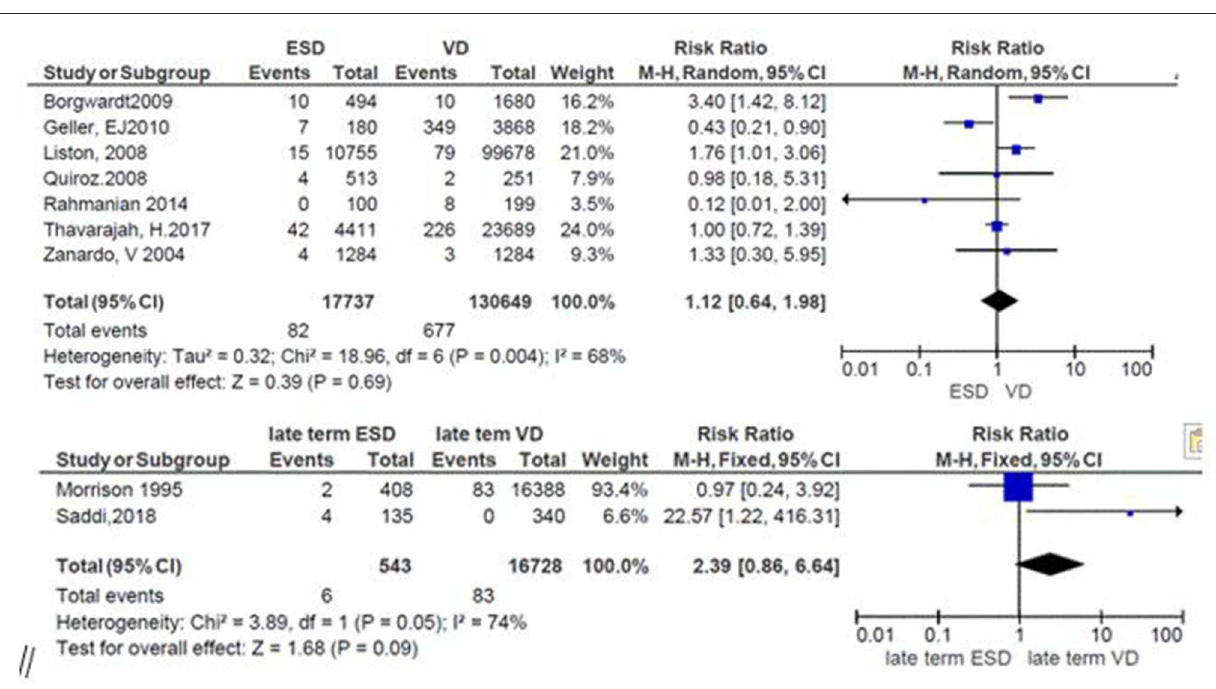
FIGURE 7 | Low Apgar scores in relation to mode of delivery,